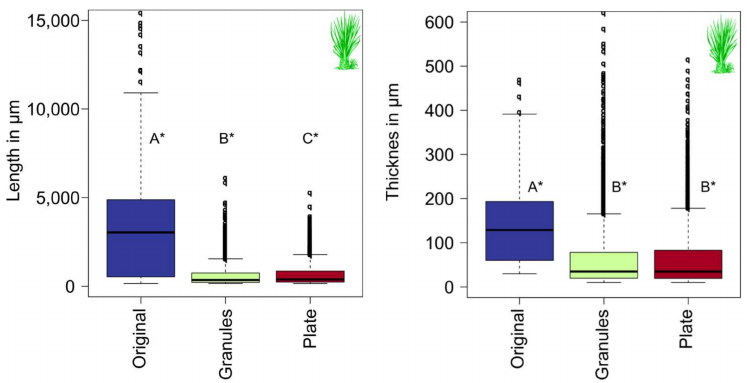
Figure 9. Distribution of the length ( left ) and width ( right ) for sisal before processing (original), after compounding (granules), and after injection moulding (plate). The results are shown as box-and-whisker plots (whiskers with a maximum of 1.5 × IQR, outliers shown as circles). Boxplots with * represent not normally distributed samples and different capitals represent significant